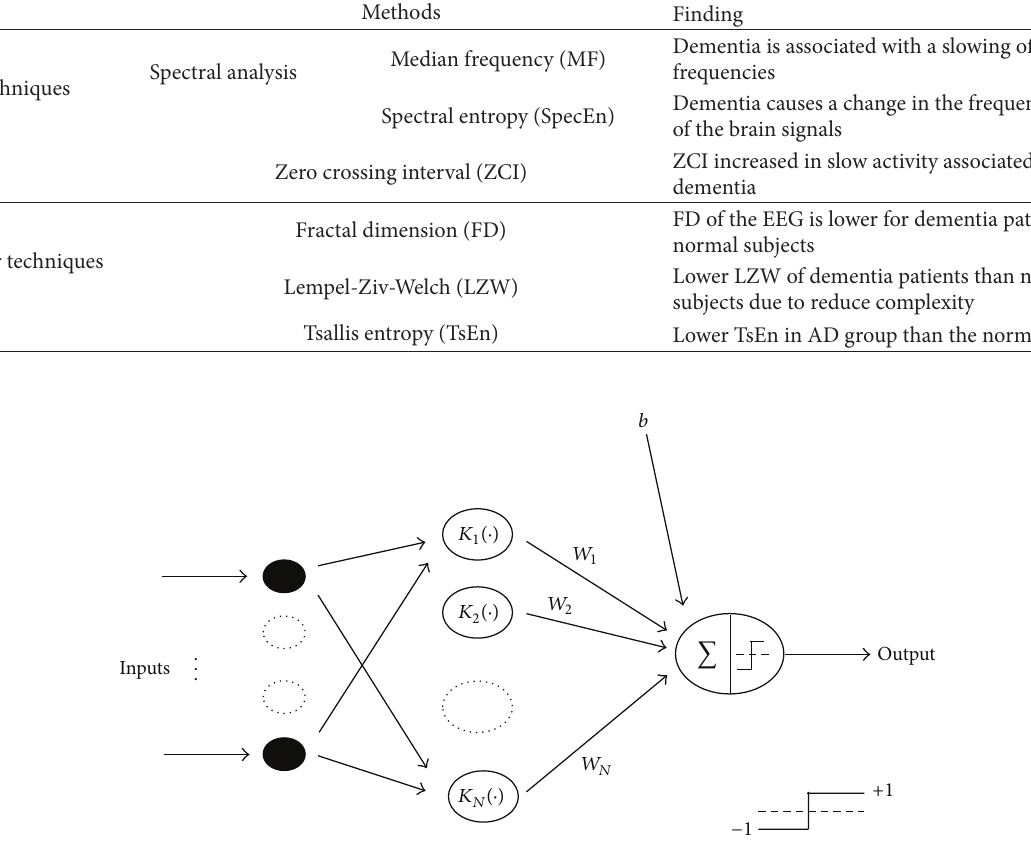
Figure 12: Support vector machine classifier